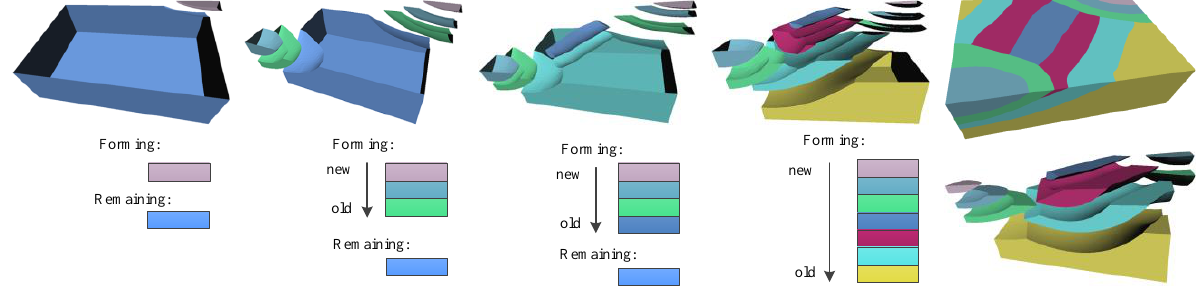
Figure 2. Sequential extraction of geological models from the fundamental body from new geologic time to old one. Step 4, by redoing the step 3, every geological interface was used to split the corresponding fundamental body from new to interfaces participated in the extraction process (Figure 2).